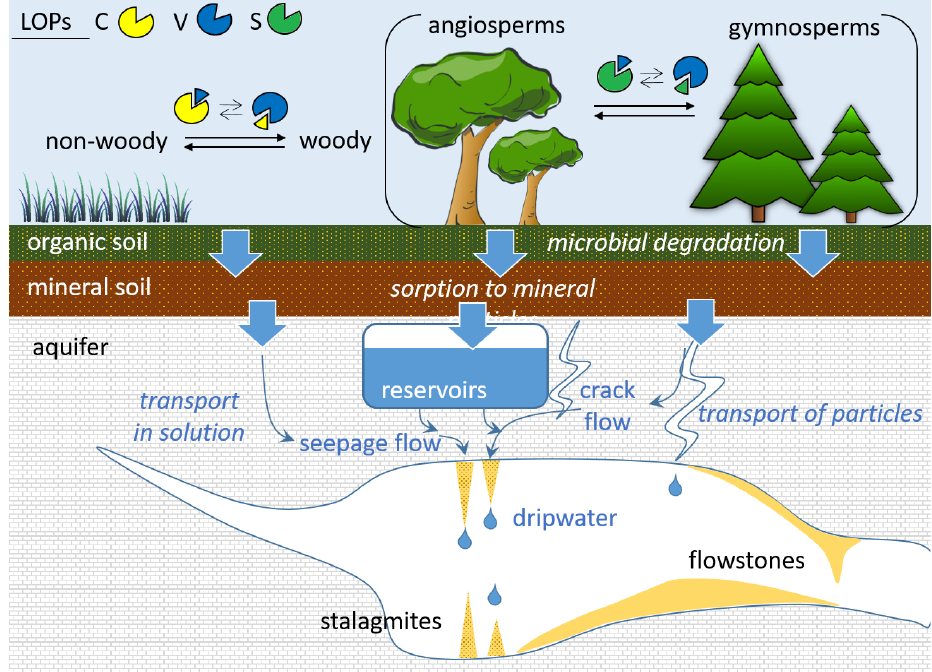
Figure 1. Schematic representation of the different potential processes influencing the transport and degradation of LOPs in speleothems and cave